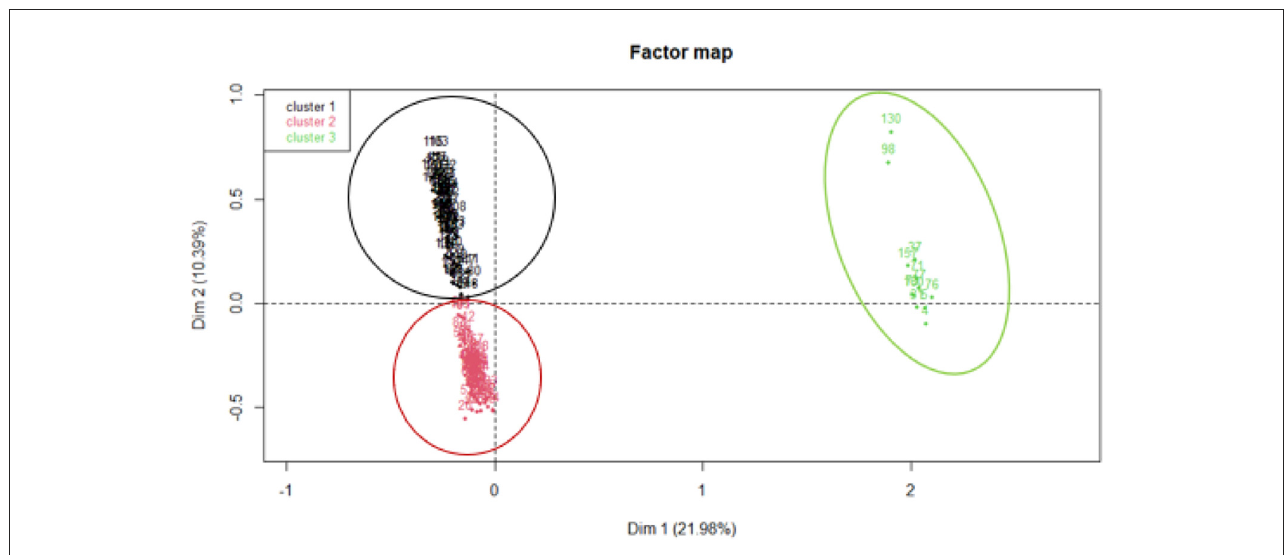
FIGURE3 Classification of female Wagashi Gassirè producers in Dassa-Zoumé and